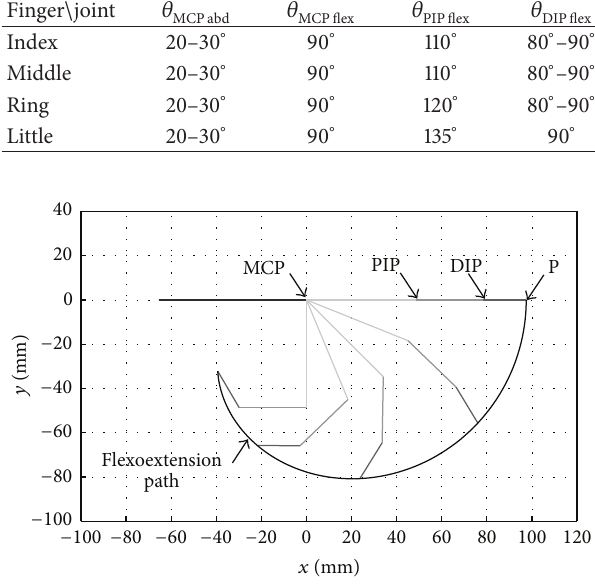
Figure 2: Flexoextension path of the kinematic chain of the three 0 ∘ ≤ DIP ≤ 60 ∘